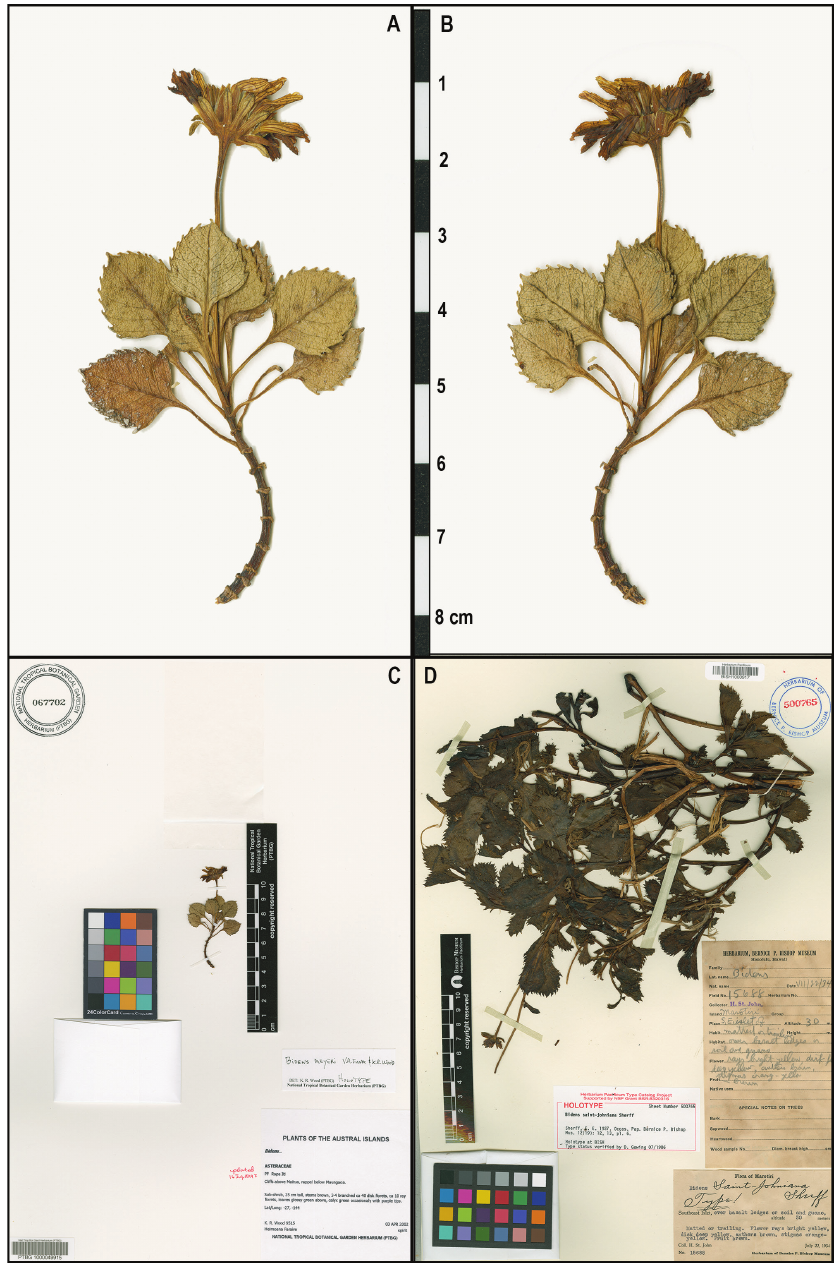
Figure 2. Photos of Bidens type specimens: A–C Bidens meyeri holotype (PTBG): A–B Specimen be- fore mounting A Side with the involucral bracts and (mostly) upper surface of the leaves showing B Side with the flowers and (mostly) the undersurface of leaves showing C Holotype of Bidens meyeri , housed at PTBG D Holotype of Bidens saint-johniana , housed at BISH. [Photo credits: A–C by Jesse Adams, PTBG; D sent by